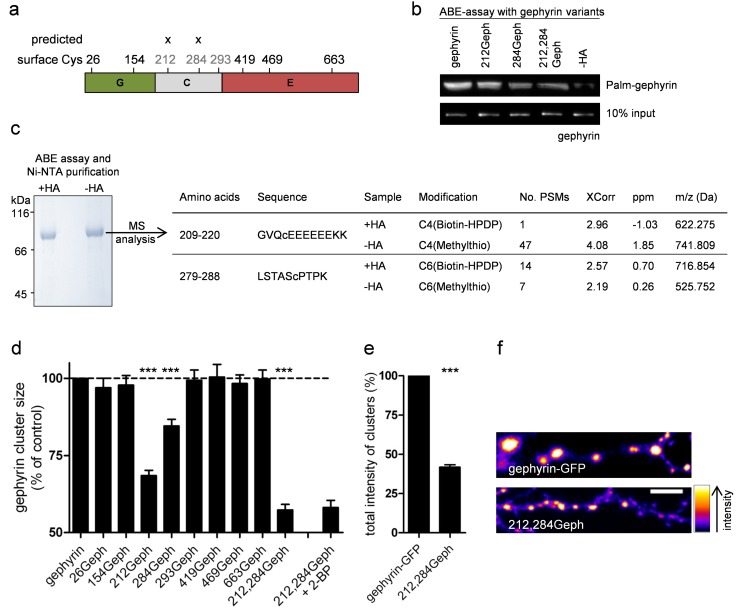
Palmitoylation on Cys212 and Cys284 is essential for gephyrin localization and clustering in neurons.(a) Scheme of gephyrin domain architecture with surface-exposed and Palm-CSS 3.0–predicted cysteine residues. (b) Immunoprecipitation of ABE-assay–processed gephyrin cysteine-to-serine mutants expressed in HEK293 cells. Streptavidin-HRP shows palmitoylation status of individual variants, whereas GFP-immunoblot was used as the loading control. Experiment was repeated three times with similar results. (c) SDS-PAGE of ABE-assay–processed and Ni-NTA affinity-purified gephyrin and LC-MS/MS analysis of the protein bands. (d) Quantitative comparison of cluster size of GFP-tagged WT and mutant gephyrin variants in primary hippocampal cultures. (e) Total intensity of WT gephyrin or 212,284Geph clusters (f) Representative dendrites of gephyrin-GFP and 212,284Geph. Scale bar, 5 µm. All quantifications are means ± SEM (***p<0.001 using Student's t test; NS, not significant). At least three independent cultures were used per experiment.